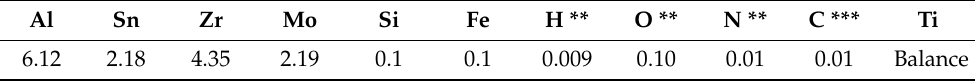
Table 1. Chemical composition of the Ti-6242 PM (wt.%) *.